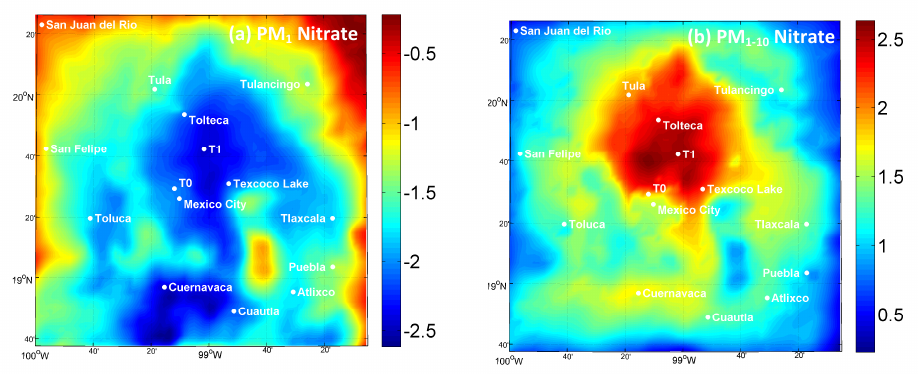
Figure 10: Predicted change in ground-level concentrations (µg m -3 ) of the (a) PM 1 nitrate and (b) PM 1-10 nitrate after using the equilibrium approach for aerosol dynamics (instead of the hybrid approach used in the basecase simulations). A positive change corresponds to an increase due to the use of the hybrid approach.